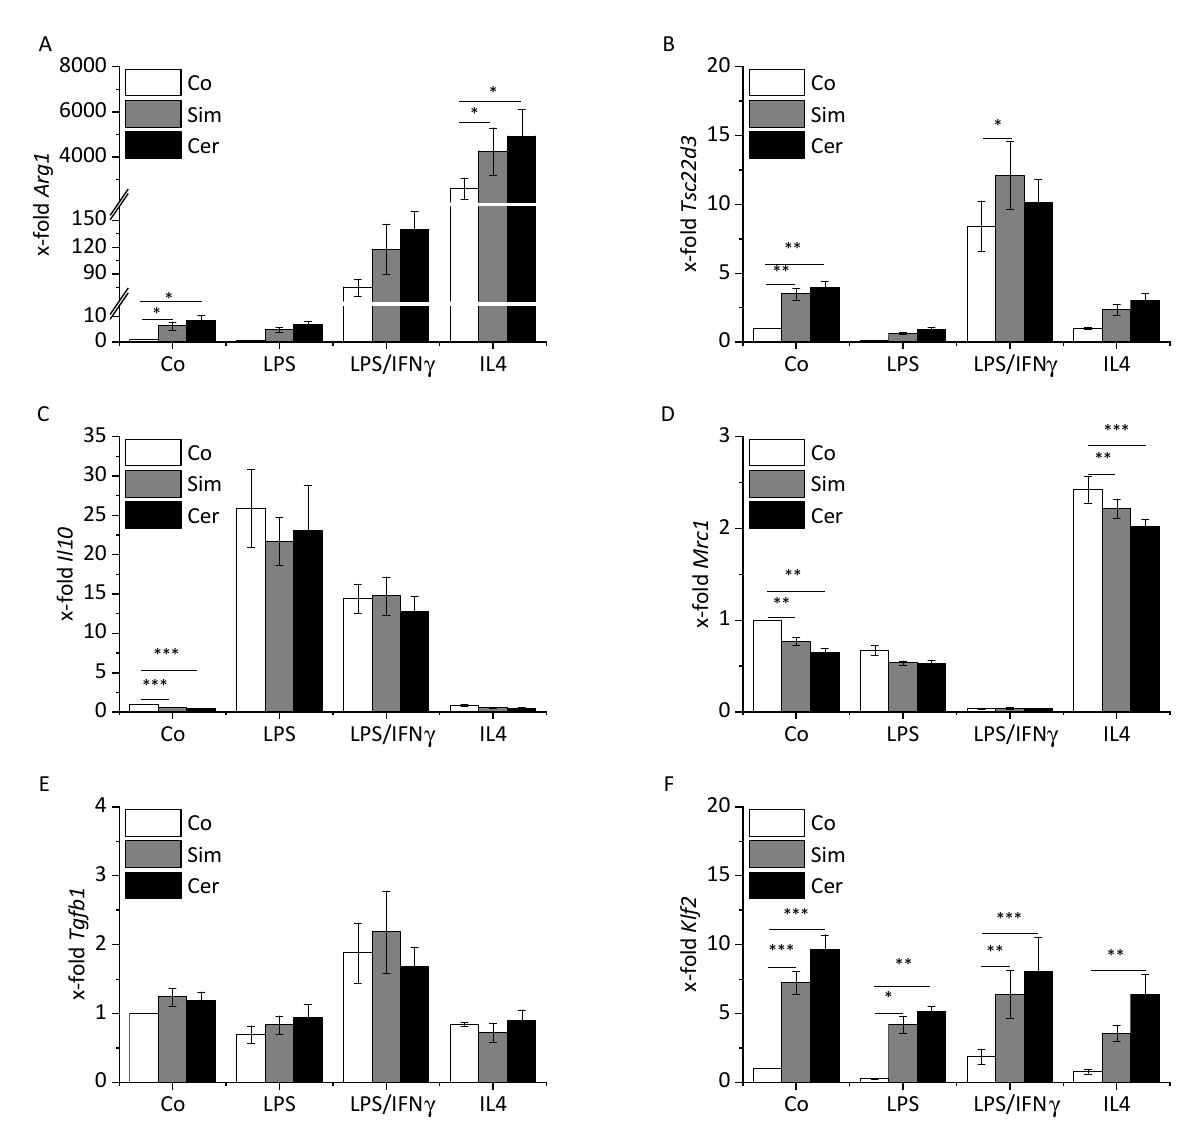
Figure 2. Effect of statin treatment on the anti-inflammatory response in macrophages. ( A – D ) Arg1 ( A ), Tsc22d3 ( B ), Il10 ( C ), Mrc1 ( D ), Tgfb1 ( E ), and Klf2 ( F ) mRNA expression in BMMs was determined by real-time RT-PCR, normalized to Ppia , and expressed as x-fold of Co. BMMs were stimulated for the last 4 h with LPS (100 ng/mL) or polarized towards M1 (LPS, 100 ng/mL; IFN γ , 20 ng/mL) or M2 (IL4, 20 ng/mL) in the presence or absence of of simvastatin (Sim, 2 µ M) or cerivastatin (Cer, 0.5 µ M) for 24 h. Co = solvent control ( n = 6). A one-sample t -test followed by a Bonholm post hoc test was used for analyzing the gene expression data of the control group. Means of more than two groups were compared by one-way ANOVA with a Bonholm post hoc test (normal distribution). * p < 0.05, ** p < 0.01, and *** p < 0.001.